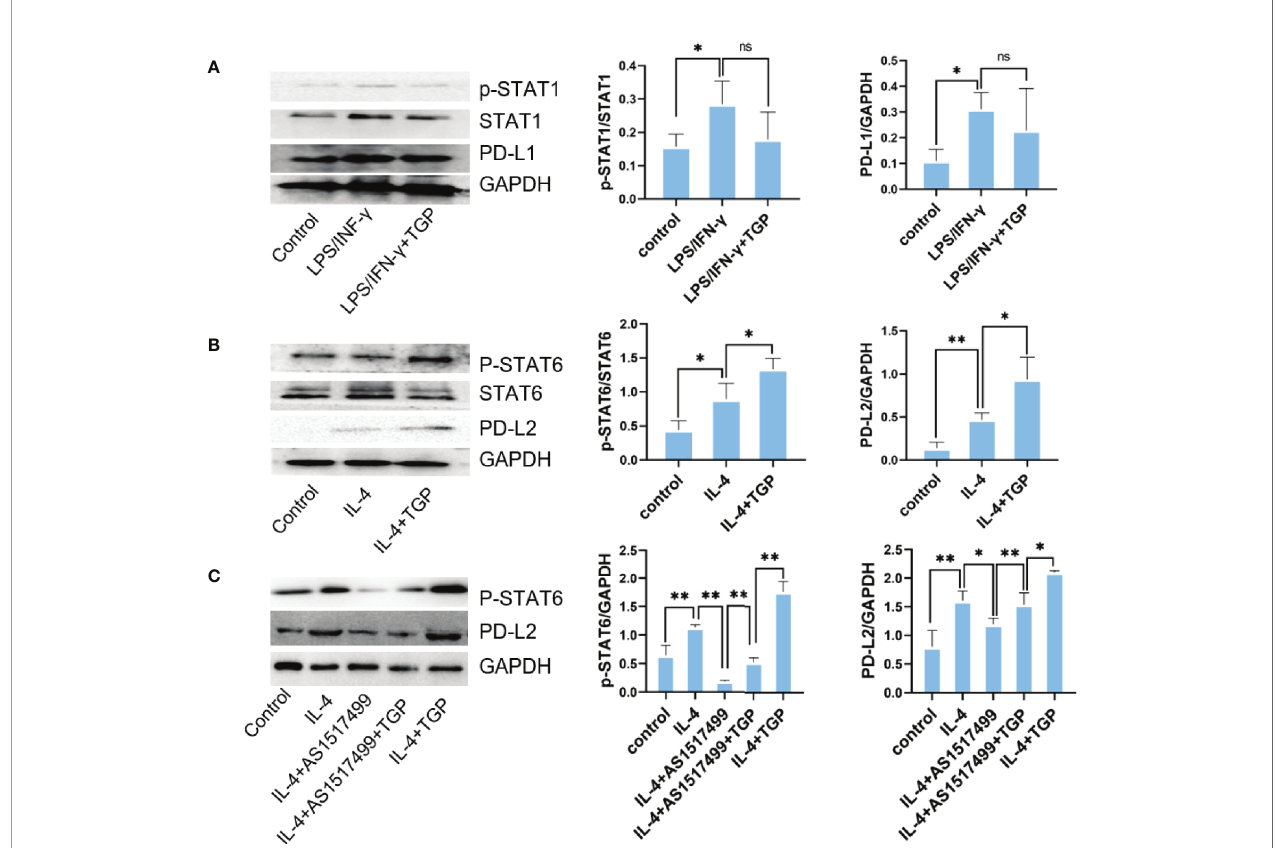
FIGURE 6 | TGP augments PD-L2 expression on macrophages via phosphorylating STAT6. (A) Raw264.7 cells were pretreated with LPS/IFN- g for 12 h and treated with TGP for another 48 h, then protein expressions of p-STAT1, STAT1 and PD-L1 were detected via western blot analyses. (B) Raw264.7 cells were pretreated with IL-4 for 12 h and treated with TGP for another 48 h, the protein expressions of p-STAT6, STAT6 and PD-L2 were then detected via western blot analyses. (C) To determine if TGP regulates PD-L2 expression via STAT6 pathway, Raw264.7 cells were treated with a STAT6 inhibitor, AS1517499, and detected for the expressions of p-STAT6 and PD-L2. Overall, GAPDH was used as internal references. The expressions of p-STAT1, STAT1, PD-L1, p-STAT6, STAT6 and PD-L2 were calculated relatively to GAPDH. Data are presented as means ± SD (n=3, **p<0.01 or *p<0.05, as indicated for direct comparisons, ns, not signi fi